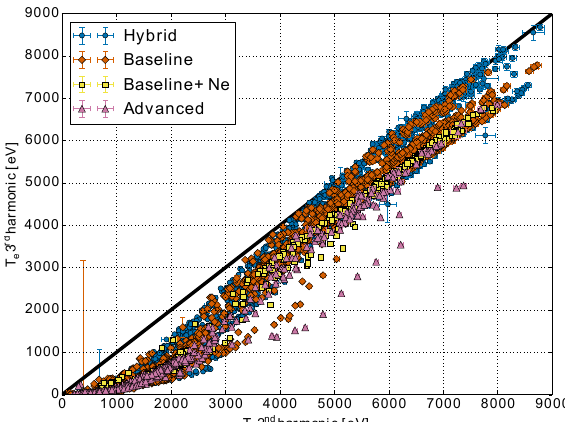
Figure 4: Comparison of central ECE and LIDAR temper- atures in DD pulses.